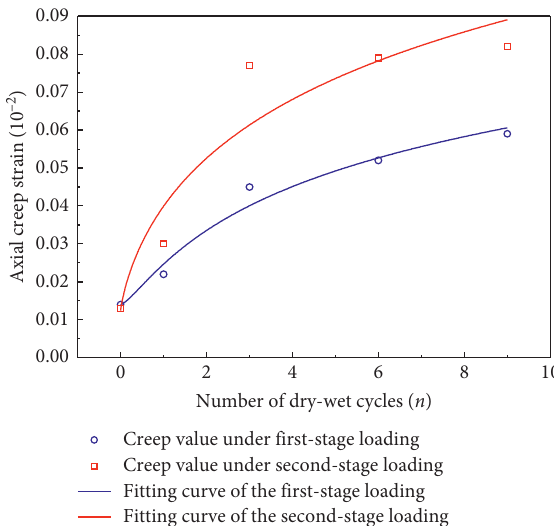
Figure 11: Creep curve of the different loading levels of the